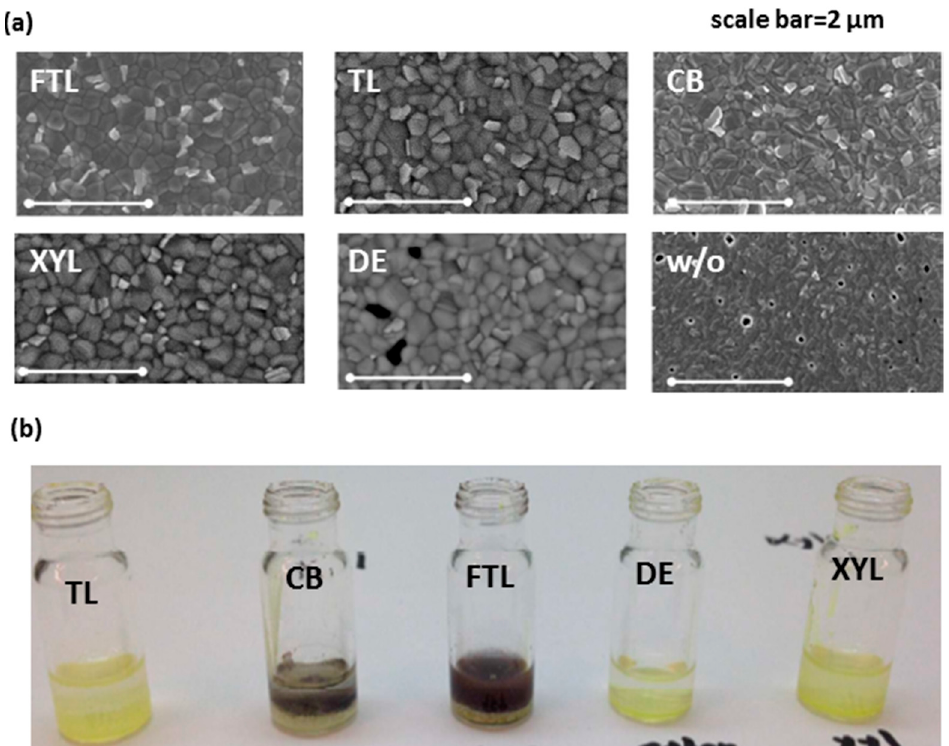
Figure 11. ( a ) SEM images of perovskite films treated (or not) by various anti-solvents (trifluorotoluene: FTL, toluene:TL, chlorobenzene: CB, xylene: XYL, diethyl ether: DE); ( b ) Photograph of adding anti-solvents into precursor solutions. Reproduced from Ref. [70] with permission from American Chemical Society.